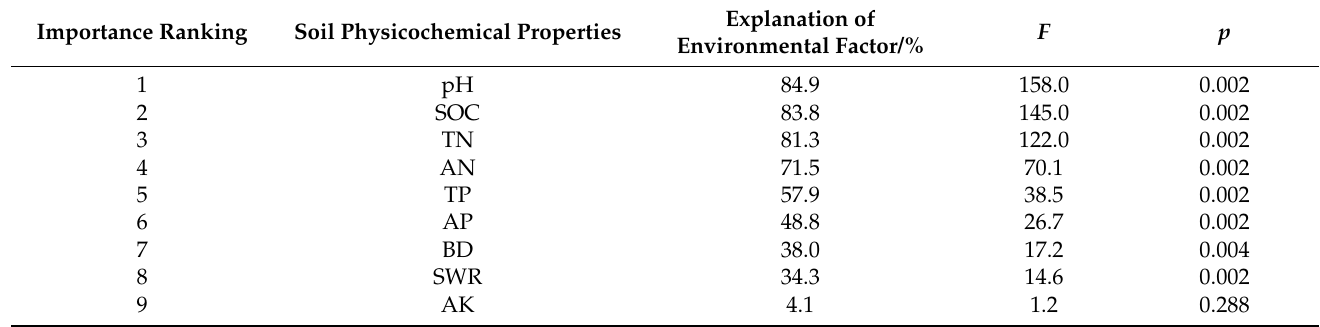
Figure 2. Redundancy analyses (RDA) of soil physicochemical properties and soil enzyme activities in ( a ) NVR land, ( b ) APR land. In ( a ), 1–15 represent the sample sites of natural forestland, 16–30 represent the sample sites of natural grassland. In ( b ), 1–15 represent the sample sites of artificial forestland, 16–30 represent the sample sites of artificial grassland. The length of the arrow line and the cosine value of the included angle represent the degree of influence of a certain physicochemical factor on soil enzyme activity. BG, β -glucosidase; URE, urease; ALP, alkaline phosphatase; BD, bulk density; SWR, soil water retention; SOC, soil organic carbon; TN, total nitrogen; TP, total phosphorus; AN, available nitrogen; AP, available phosphorus; AK, available potassium. Table 5. Importance and significance level of soil physicochemical properties in NVR land.